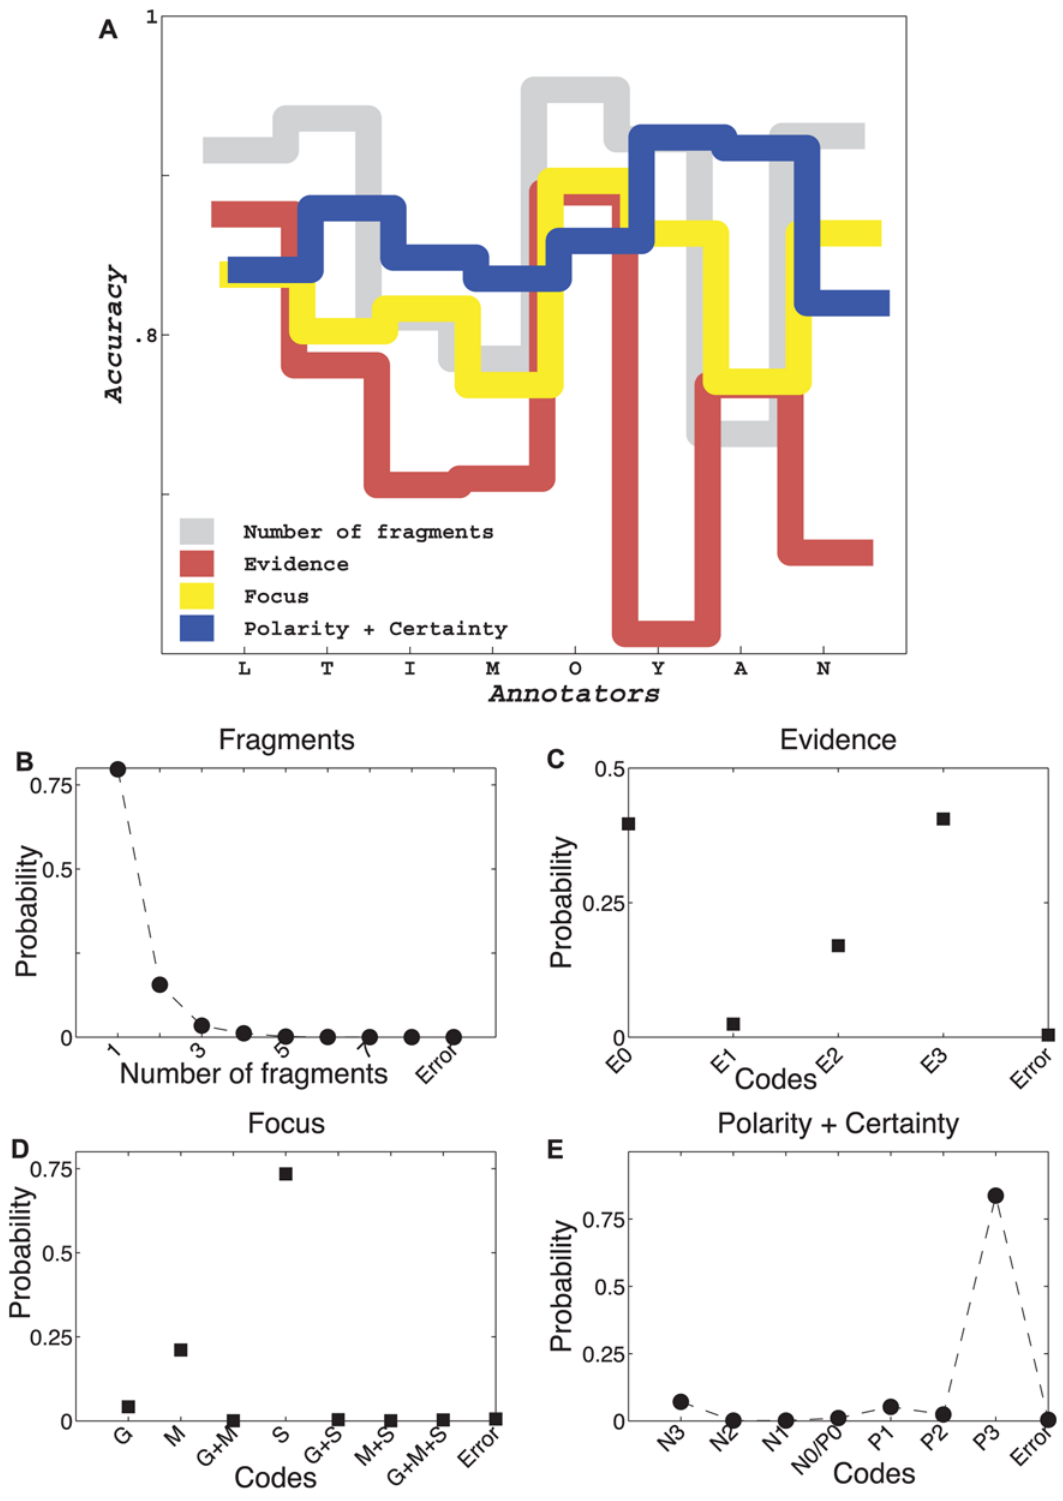
Figure 5. Estimates of parameters defined under Model B-with-thetas from real data. (A) Estimates of correctness parameter values for eight annotators across multiple annotation types. While these values are different from those estimated under Model A, (Figure 4 A), the estimates are clearly consistent across the two models. (B–E) Estimates of c -distributions, where c i is the probability that the i th annotation code is correct. Note that c -distributions are similar but not identical to distributions of v -values shown in Figures 4 (F–I).